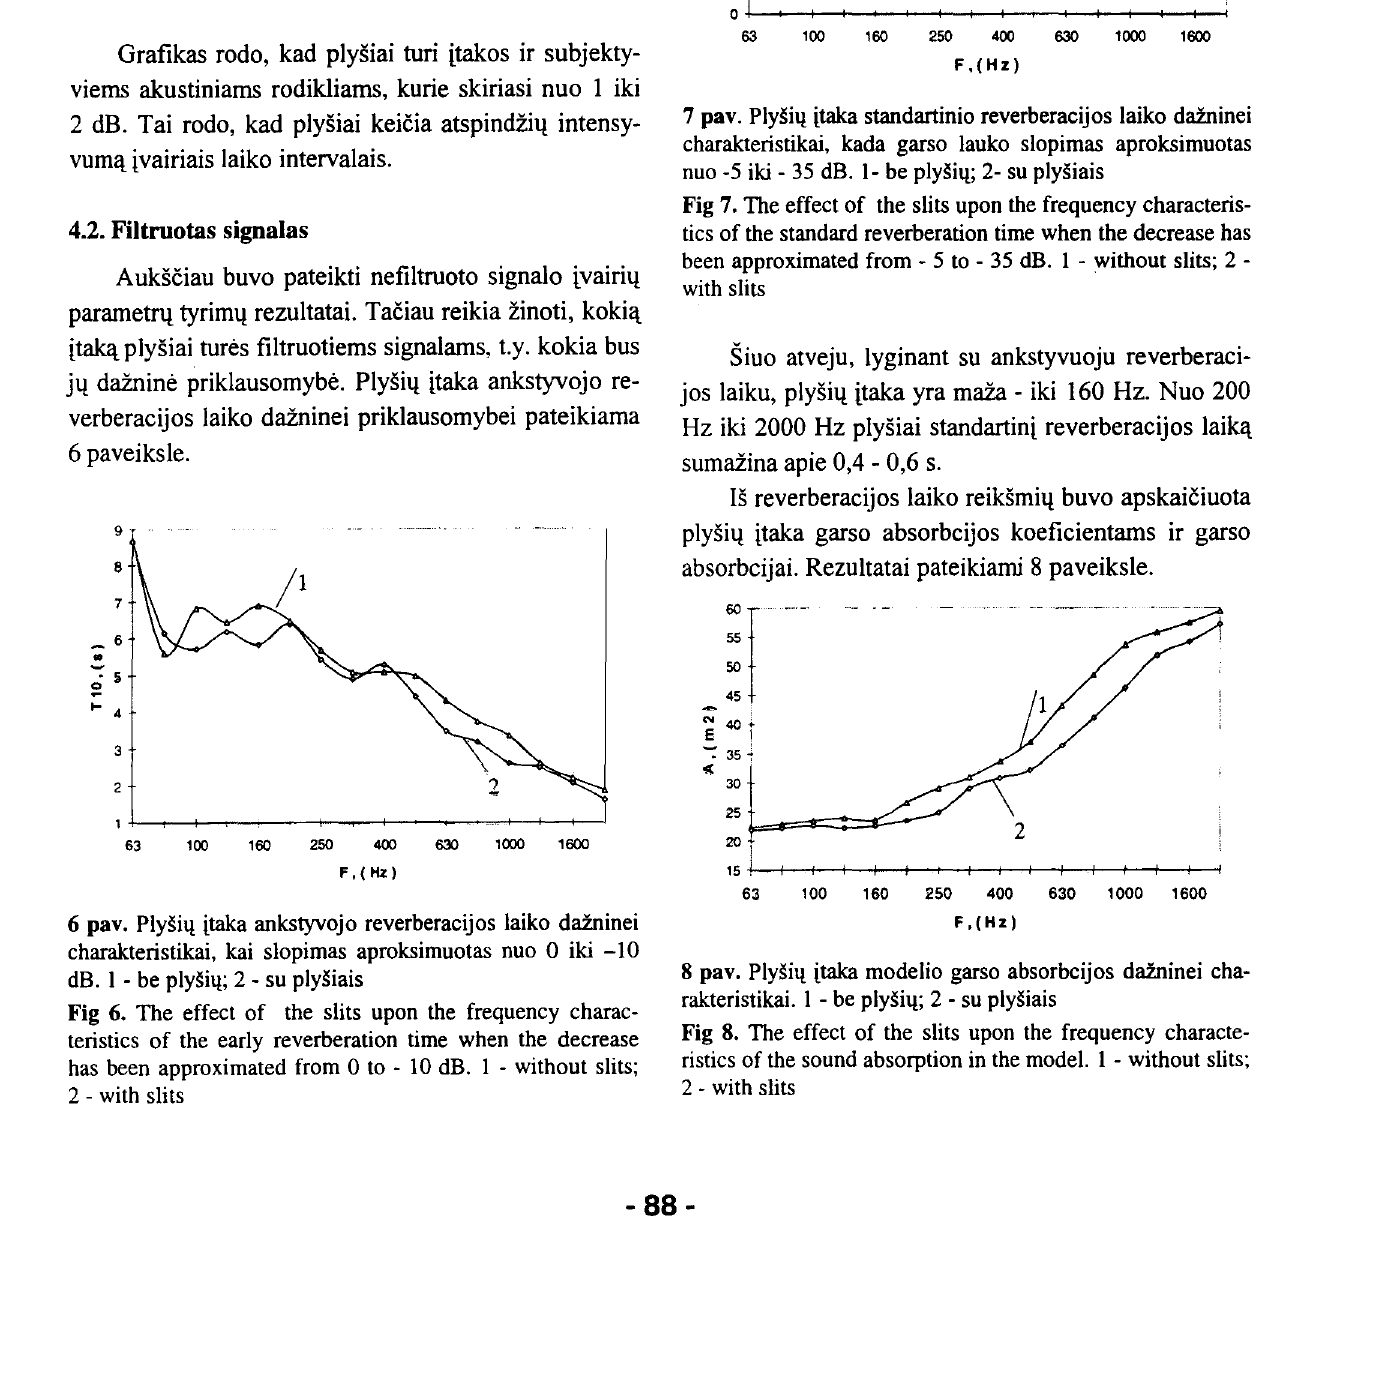
Fig 8. The effect of the slits upon the frequency characte ristics of the sound absorption in the model. I - without slits; 2 - with slits